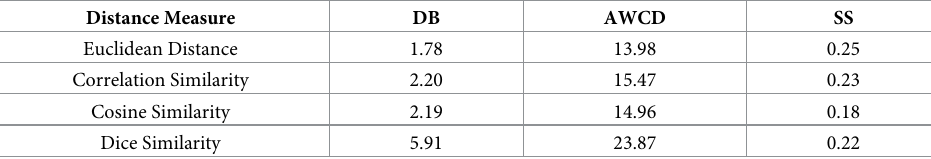
Table 7. Comparison of average clustering performance based on distance